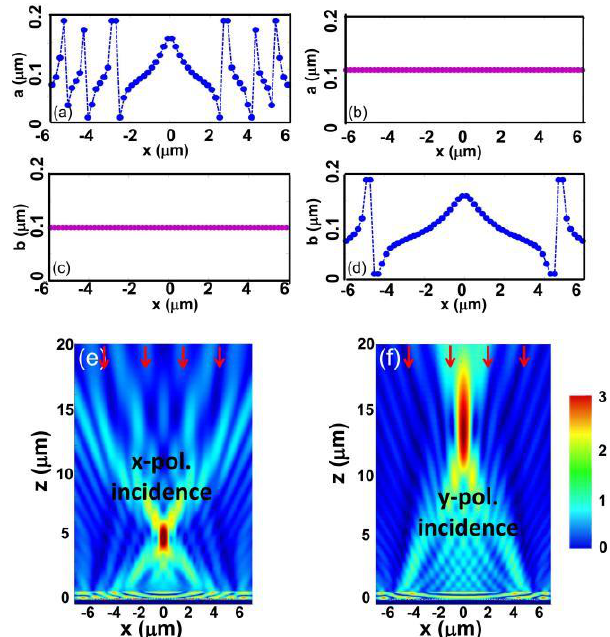
Figure 4. ( a ) X-direction length a and ( c ) y-direction length b of the metalens for x-focusing only. ( b ) X-direction length a and ( d ) y-direction length b of the metalens for y-focusing only. The electric field intensities for ( e ) x- and ( f ) y-polarization incidence, respectively.